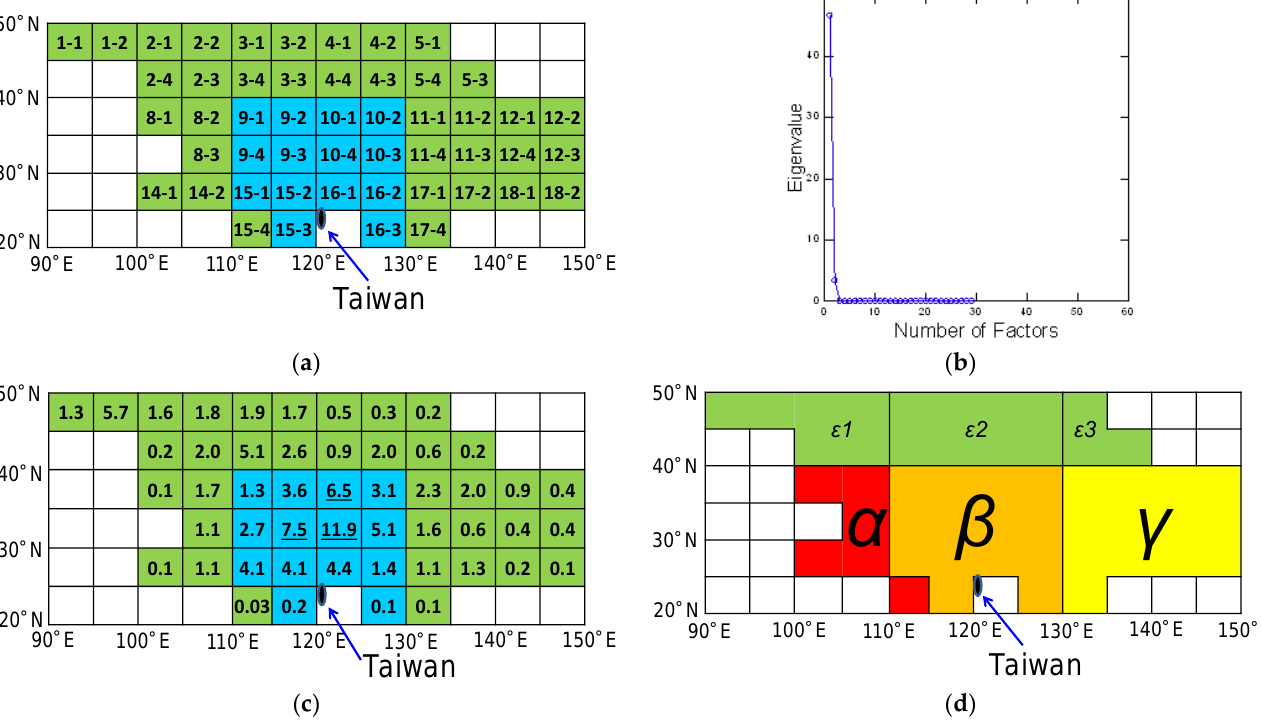
Figure 3. Association between the atmospheric environment in the Taipei metropolis and location of the continental high-pressure system (CHPS) as calculated using principal component analysis (PCA). ( a ) Assigned number of the location of CHPS centre. ( b ) Number of major factors and their eigenvalues. ( c ) Frequency (%) of the location of CHPS centres. Green regions indicate the first component of PCA, and blue regions indicate the second component of PCA on nine parameters. The Taiwan island is indicated as the dark region. ( d ) Four sub- groups (α, β, ɣ , ε). R - ε included sub-regions ε1, ε2, and ε3.